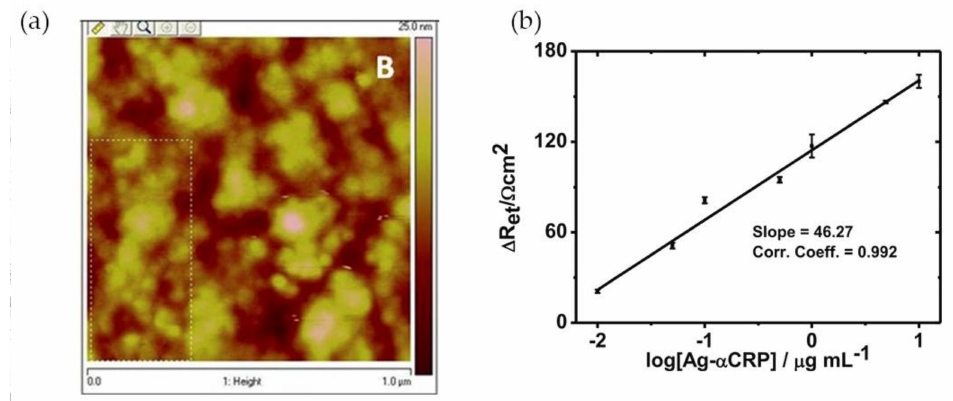
Figure 4. ( a ) Atomic force microscopy (AFM) image of Ab- α CRP/Au(MPA)-PPy-glass electrode; ( b ) Illustration of calibration curve of bioelectrode. Reproduced with permission from ref. [12]. Copyright Springer Science+Business Media New York,